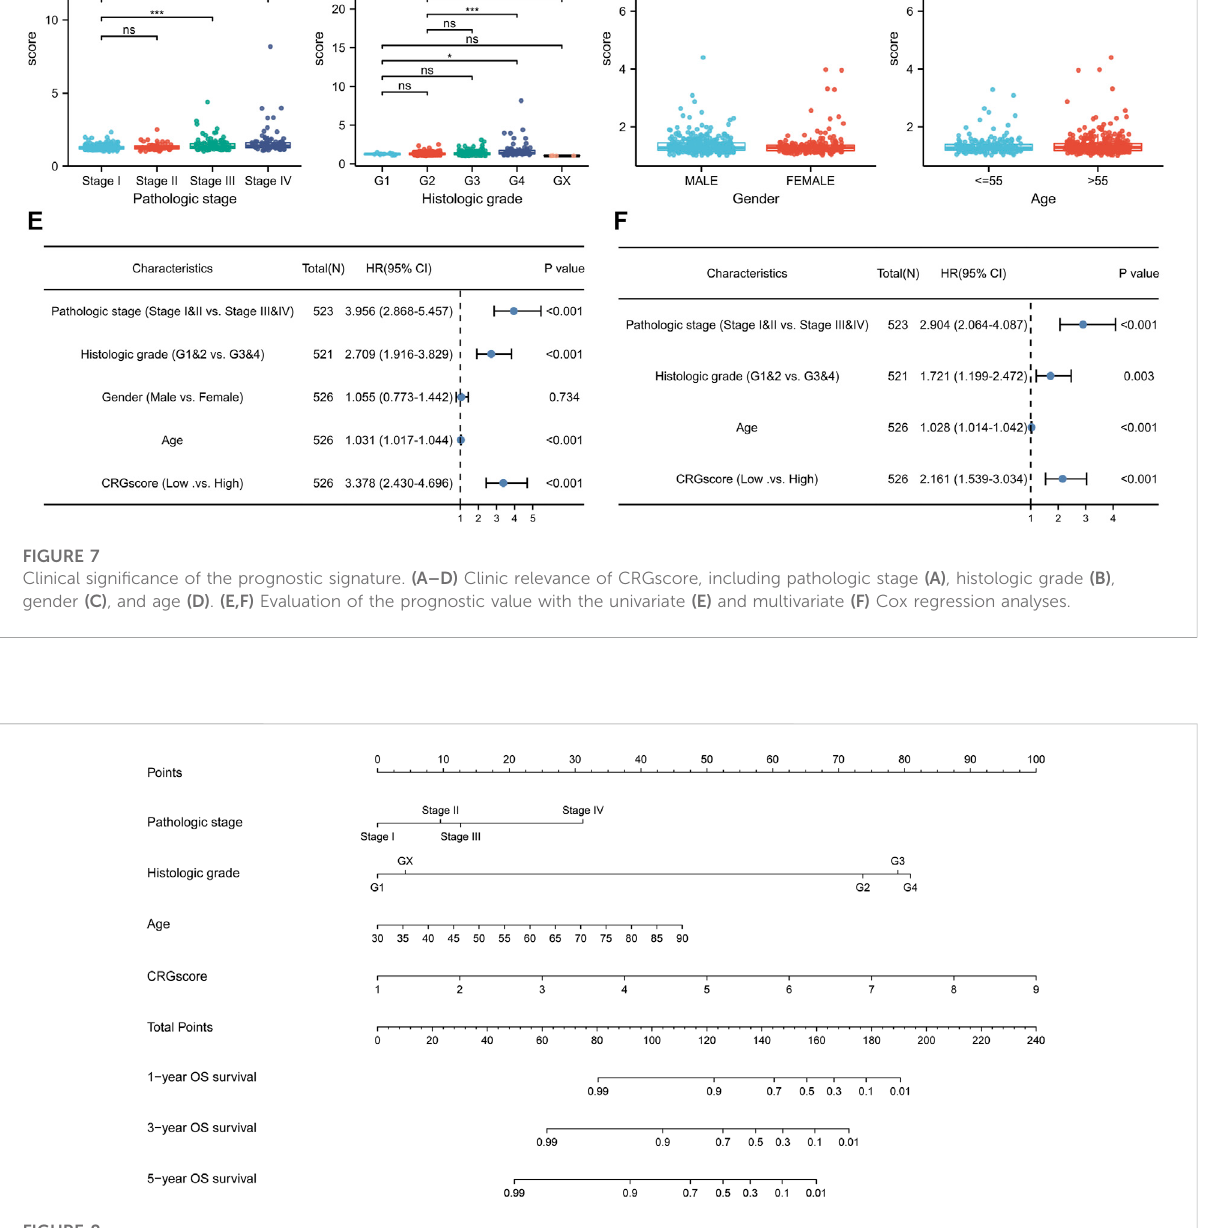
FIGURE 8 Nomogram to predict overall survival rate at 1, 3, and 5